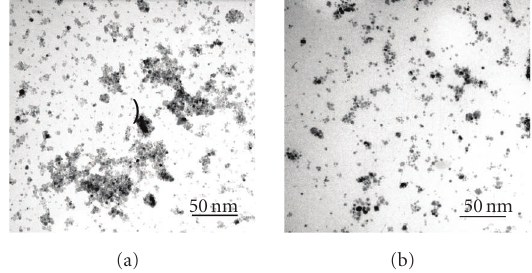
Figure 4: Transmission electron micrograph of 2-pyrrolidone- coated SPIONs (a), PVLA-coated SPIONs